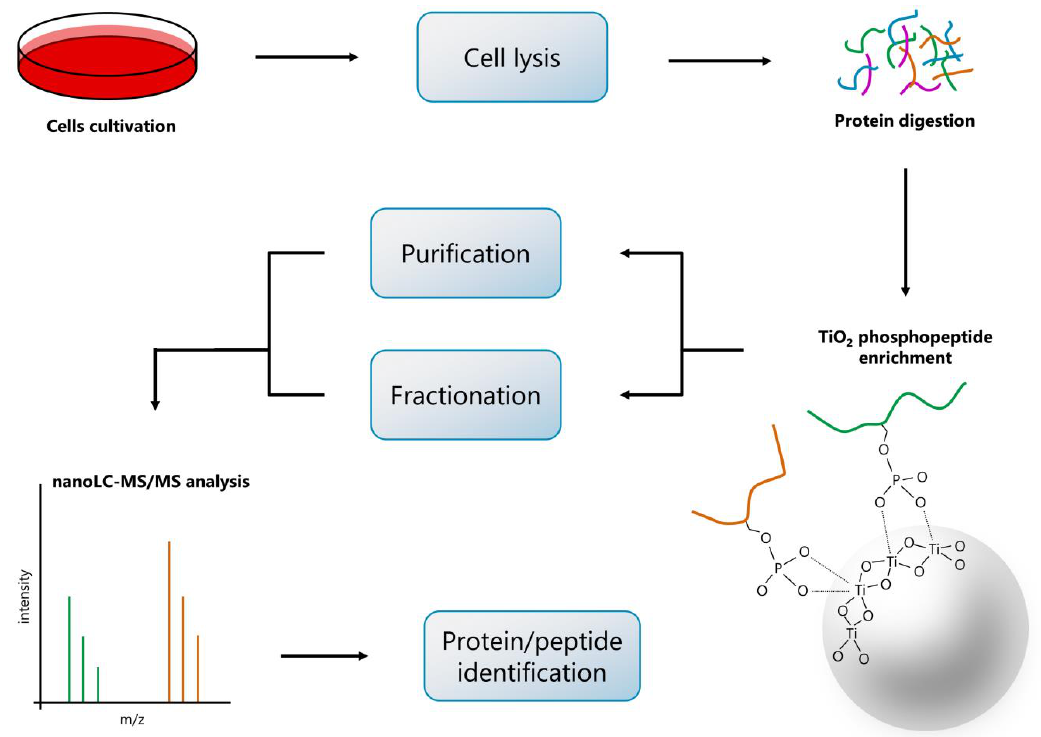
Figure 1. The workflow of sample processing. All samples were processed in the same way except for the step following after the TiO 2 enrichment, where two types of samples were prepared: 1. TiO 2 -enriched phosphopeptides further purified on C18 reversed-phase (RP) microcolumn (single fraction); 2. TiO 2 -enriched phosphopeptides further fractionated on C18 RP microcolumn using manually formed pH / acetonitrile microgradient (17 fractions).